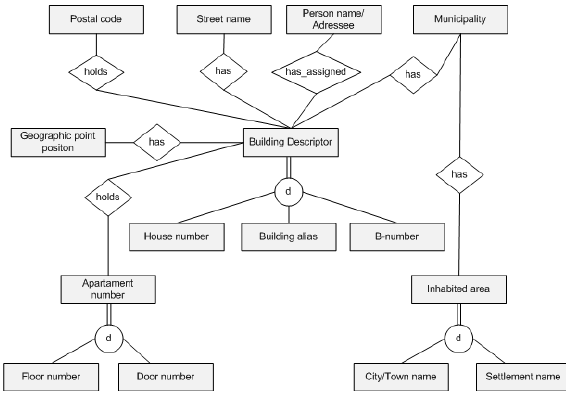
Figure 6: Enhanced entity relationship